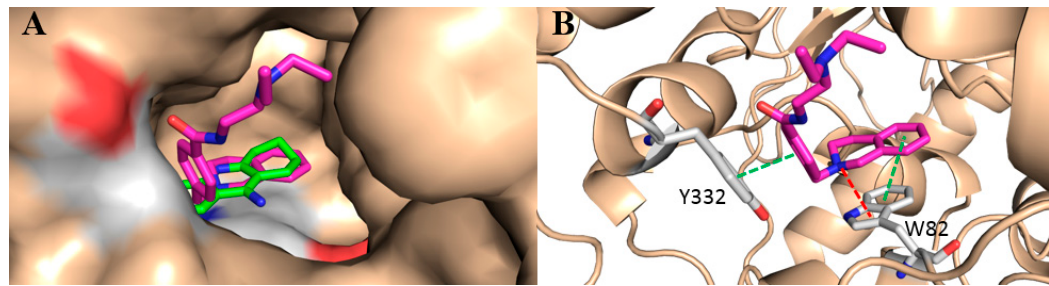
Figure 2. Proposed binding mode of hit 1 with BChE. ( A ) The predicted orientation of 1 (carbon in magenta) in the active pocket of BChE (PDB: 4BDS) with tacrine as ligand in green color; ( B ) The key interactions of 1 with residues in the active sites of BChE. π - π stacking and cation- π interaction are displayed in green and red dashed lines, respectively.